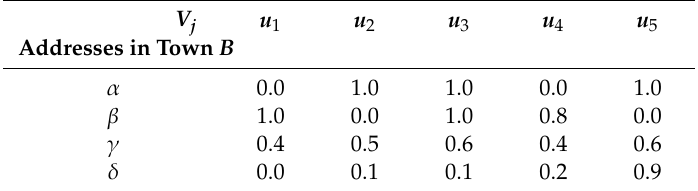
Table 4. Attribute value appurtenance fuzzy degree function for j ∈ A on Town B ( h j ).